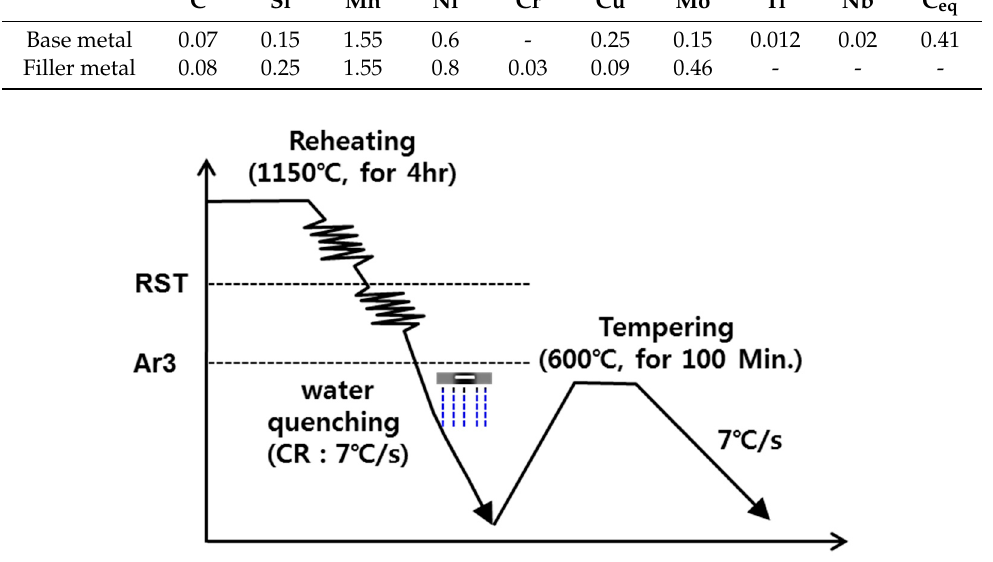
Figure 1. Schematic illustration to produce the base metal.